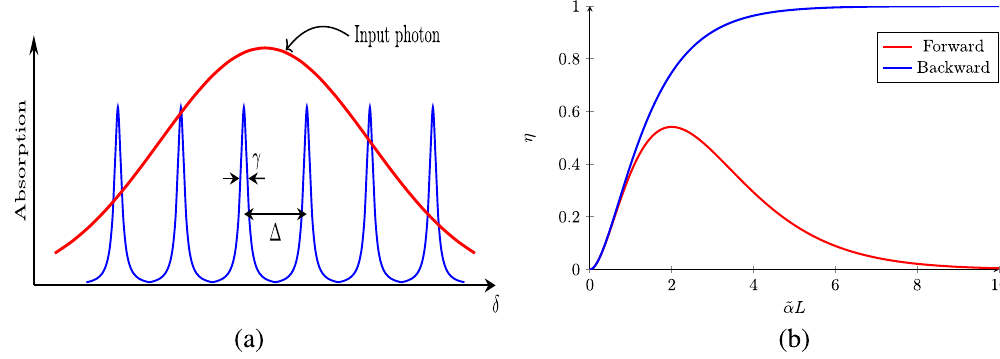
Figure 1. ( a ) AFC with tooth width γ and comb spacing (cid:31) . The red curve shows the spectrum of width γ p of the incoming photon which interacts with the AFC. For the AFC to work efficiently γ p backward efficiency η for AFC as a function of optical depth